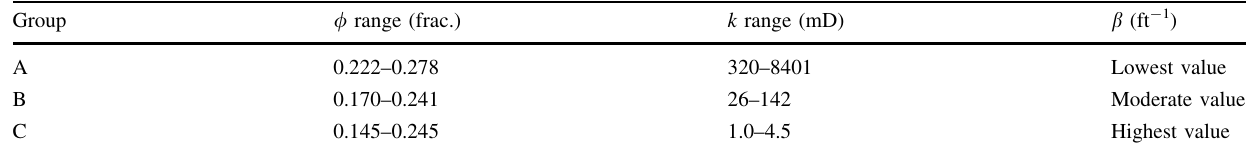
Table 2 Porosity and permeability ranges of different groups and the corresponding turbulence factor properties of the studied samples Group / range (frac.)